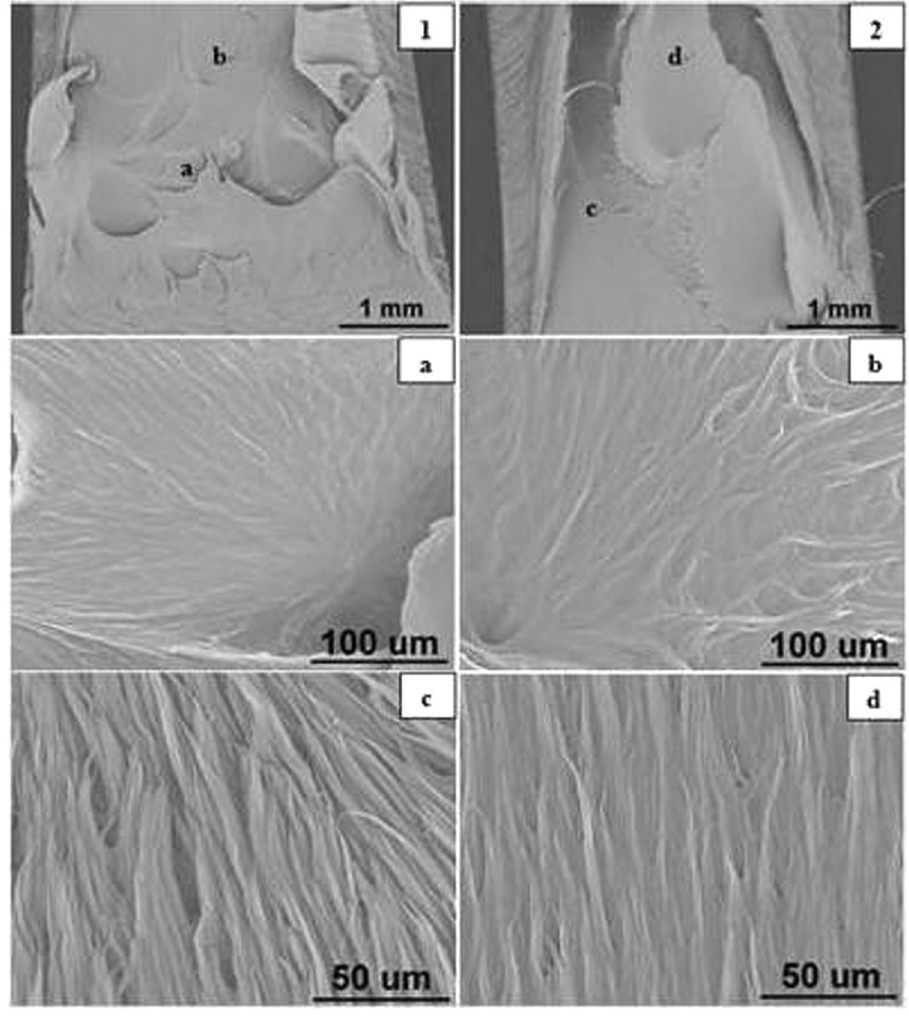
Figure 14. SEM images of blunt notched HDPE fracture surfaces at 100 mm/min (1) notch at the bottom, crack propagating from bottom to top; (2) top of propagation at 25